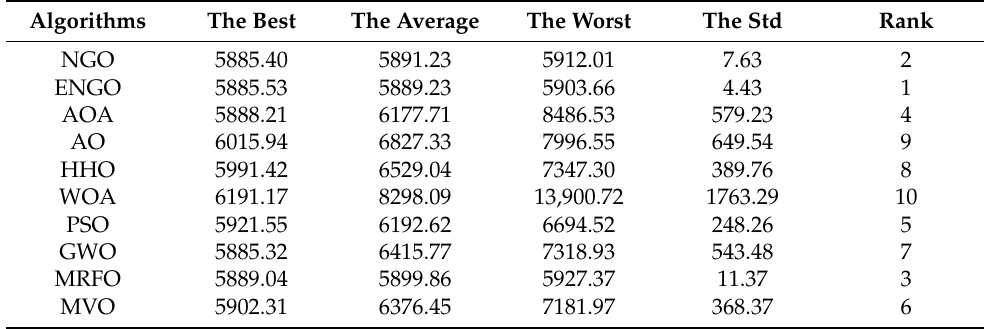
Table 6. Results of the different algorithms in solving the pressure vessel design problem.